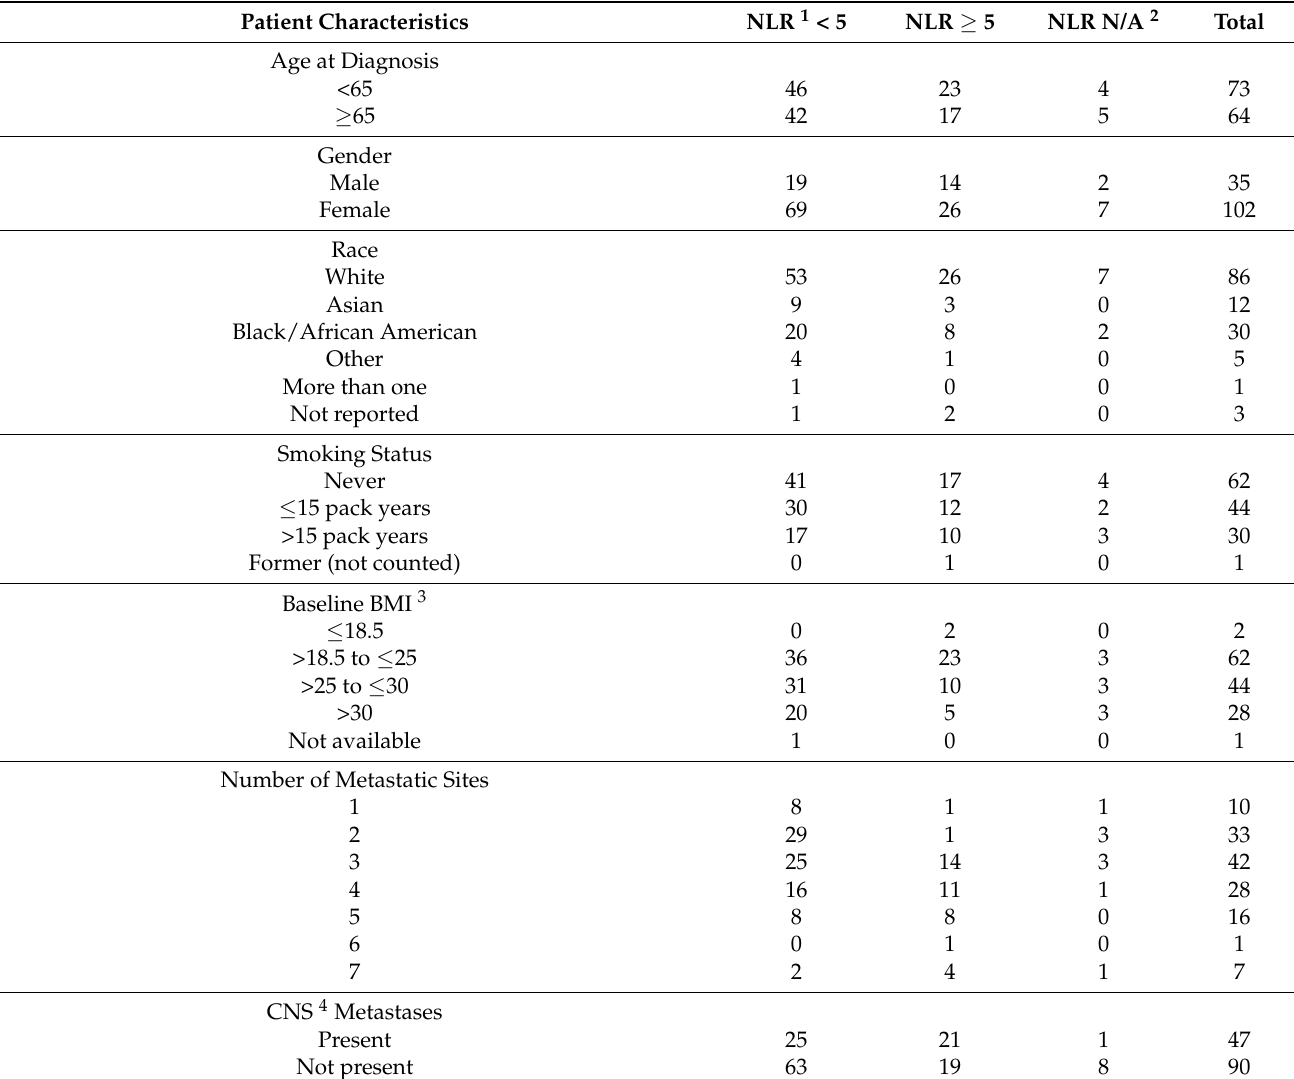
Table 1. Baseline patient characteristics and distribution divided by neutrophil-to-lymphocyte ratio (NLR) at therapy start. Patient